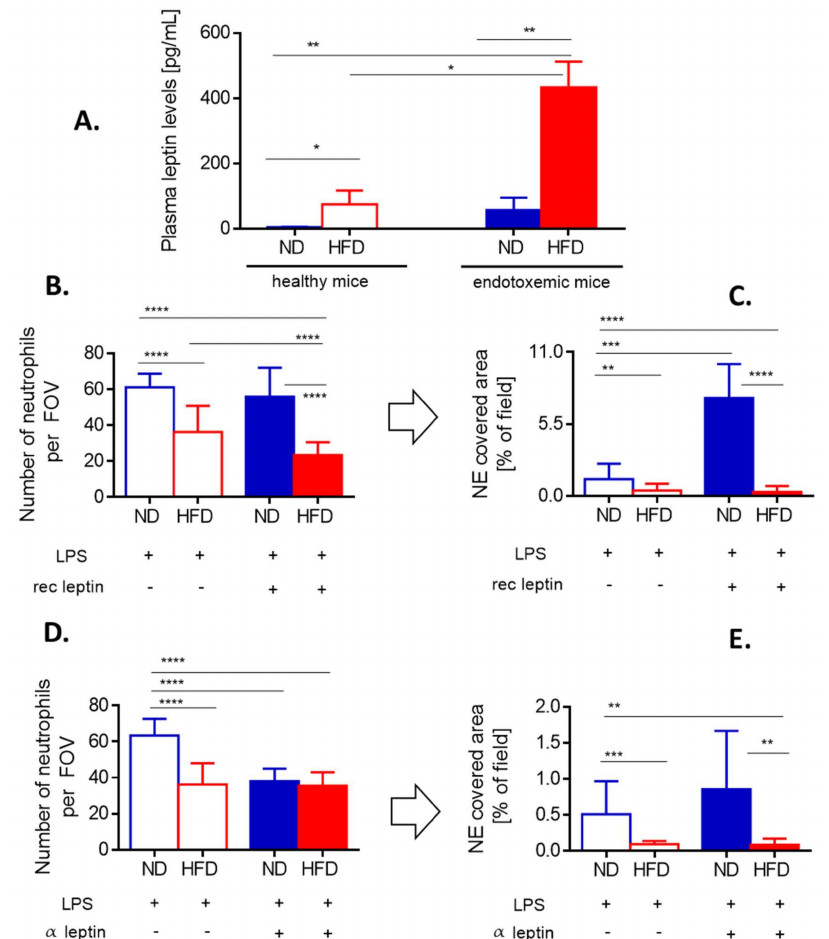
Figure 4. Leptin levels and impact of either exogenous leptin or endogenous leptin neutralization on neutrophil accu- mulation and neutrophil extracellular trap (NET) formation in liver sinusoids of lean (ND) and obese (HFD) mice. ( A ) Levels of leptin were compared between untreated (healthy) ND and HFD animals as well as endotoxemic mice, 24 h post lipopolysaccharide (LPS) injection. Some animals received a bolus of exogenous recombinant leptin (rec leptin) prior to endotoxemia induction, and subsequently neutrophil infiltration ( B ) and NET formation ( C ) in the liver vasculature were estimated. Control mice received saline. Another group of mice received mouse anti-Leptin/OB antibody to neutralize their endogenous leptin ( α leptin) whereas respective controls were injected with an isotype control as detailed in Section 2.4. Upon induction of endotoxemia, neutrophil accumulation ( D ) and NET formation ( E ) in liver sinusoids were studied. Asterisks indicate significant differences between ND and HFD mice using unpaired two-tailed Student’s t -test (* p ≤ 0.05, ** p ≤ 0.01, *** p ≤ 0.001, **** p ≤ 0.0001). Data are shown as mean ± s.d.; n ≥ 3 per